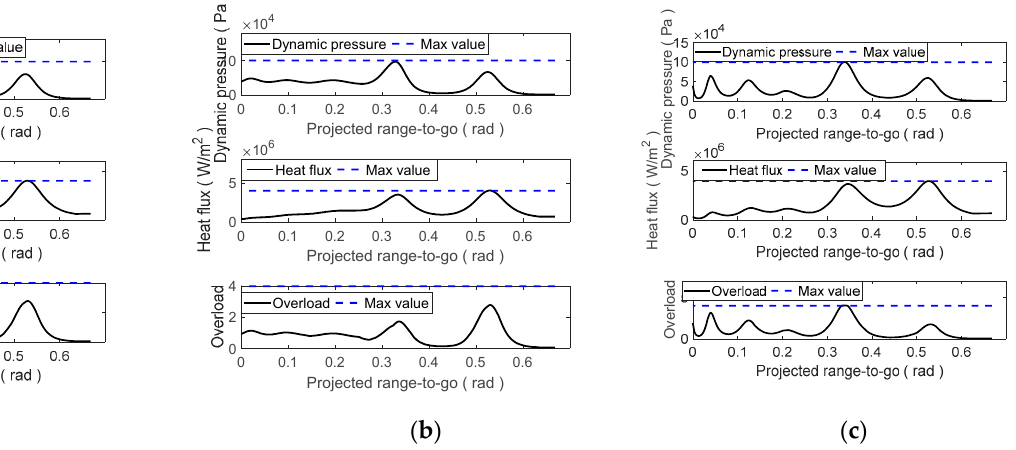
Figure 7. The grid points and control angle: ( a – c ) are the distributions of the grid points and control angles of case 1, 2 and 3, respectively.